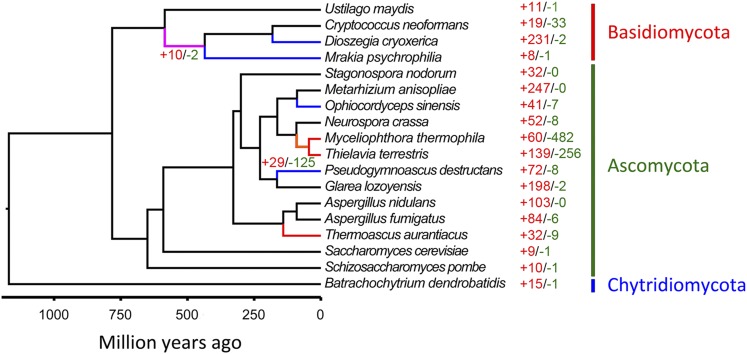
Gene family expansion and contraction in fungal genomes. The gene families that have undergone expansion and contraction are shown in red and green, respectively. The psychrophilic fungi branches are shown in blue; the thermophilic fungi branches are shown in red; the Tremellomycetes branch is shown in purple; and Chaetomiaceae branch is shown in orange.